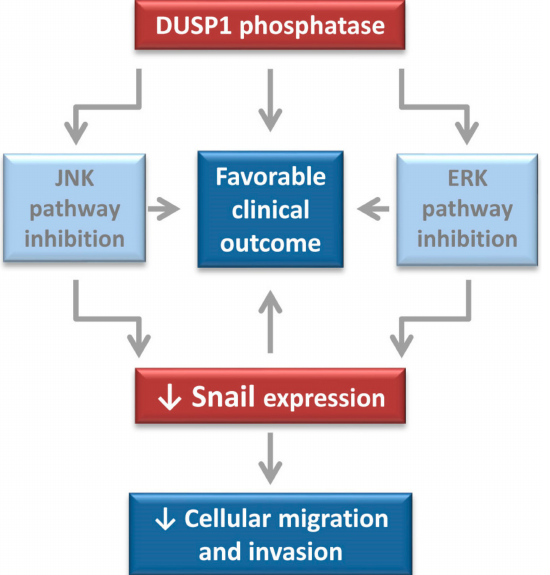
Figure 9. The phosphatase DUSP1 regulates metastasis-associated events in prostate cancer. This study demonstrate that DUSP1 overexpression downregulates Snail levels and decreases cell mi- gration and invasion. Moreover, DUSP1 inactivates ERK and JNK pathways, whose inhibition exert similar effects on Snail expression, cell migration and invasion than overexpression of the phosphatase. In addition, JNK and ERK cooperate to regulate Snail expression, cell migration and invasion through different mechanisms. Finally, in clinical samples, the expression pattern DUSP1 high /activeJNK low /activeERK low /Snail low is associated with overall extended survival of pa- tients and may serve as potential biomarker for identifying patients with favorable clinical